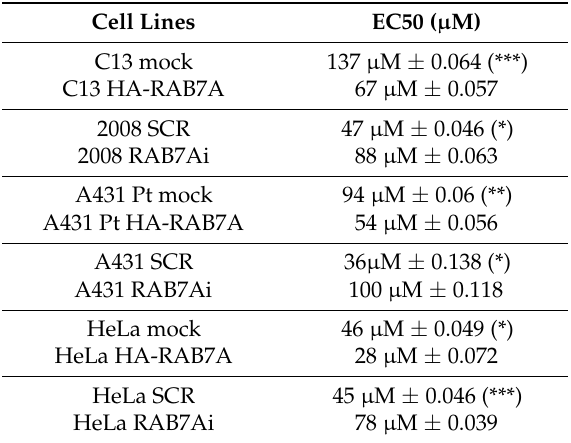
Table 1. Cisplatin (CDDP) EC 50 values in RAB7A overexpressing and silenced cell